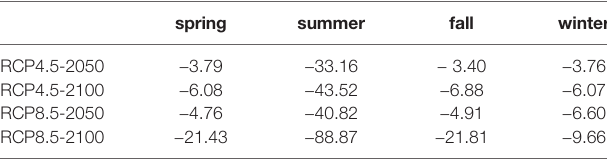
TABLE 2 | Habitat changes of Scomberomorus niphonius under future climate scenarios.